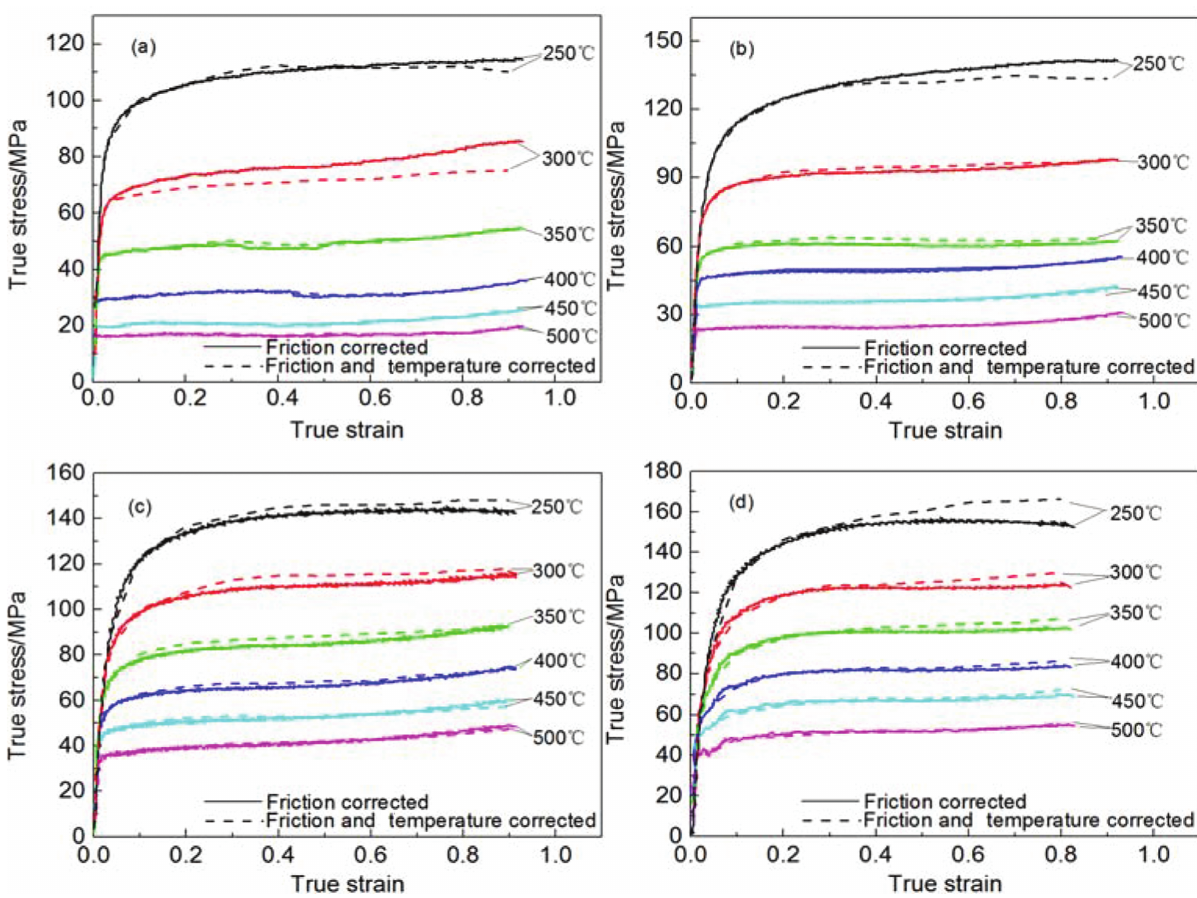
Figure 2: Friction-corrected and friction – temperature-corrected stress – strain curves: (a) 0.01 s − 1 ; (b) 0.1 s − 1 ; (c) 1 s − 1 and (d) 10 s − 1